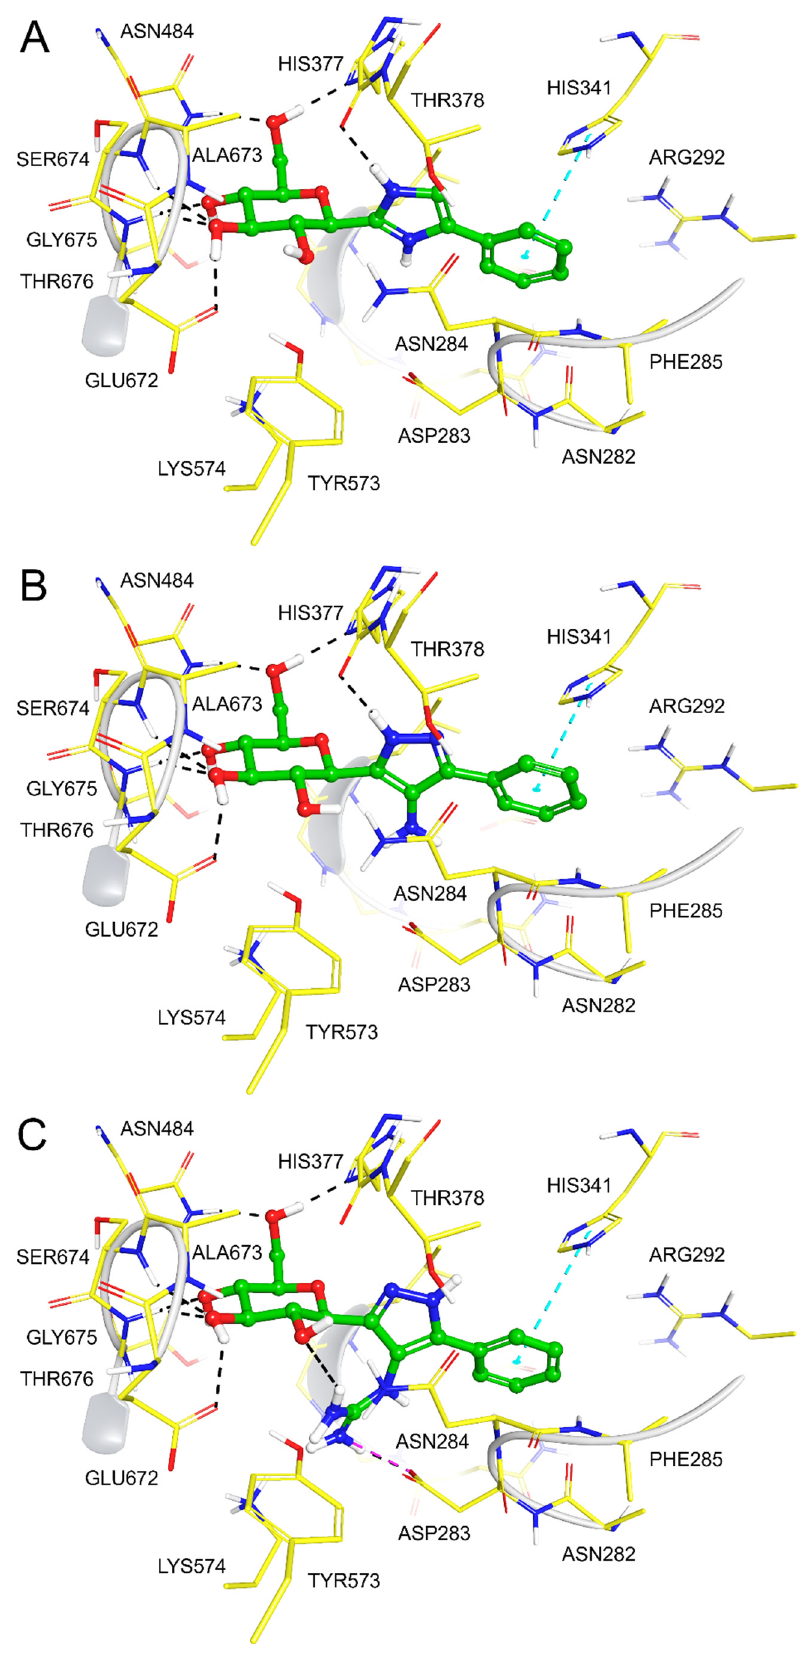
Figure 3. Binding modes of ( A ) 1 , ( B ) 3 and ( C ) 4 following post-docking MM-GBSA calculations.